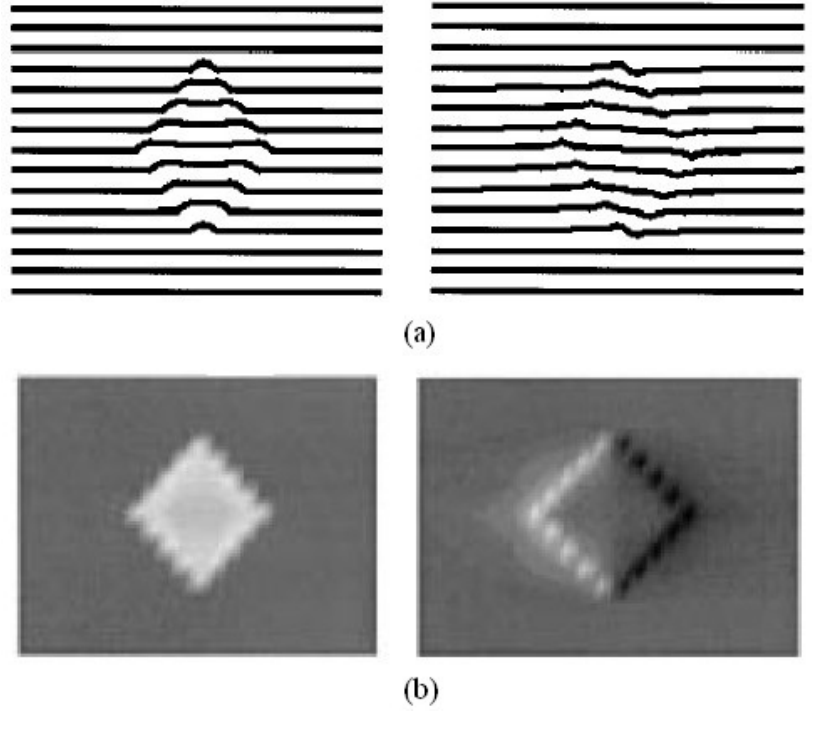
Figure 8. Composed images of the artificial hollowed rhombic